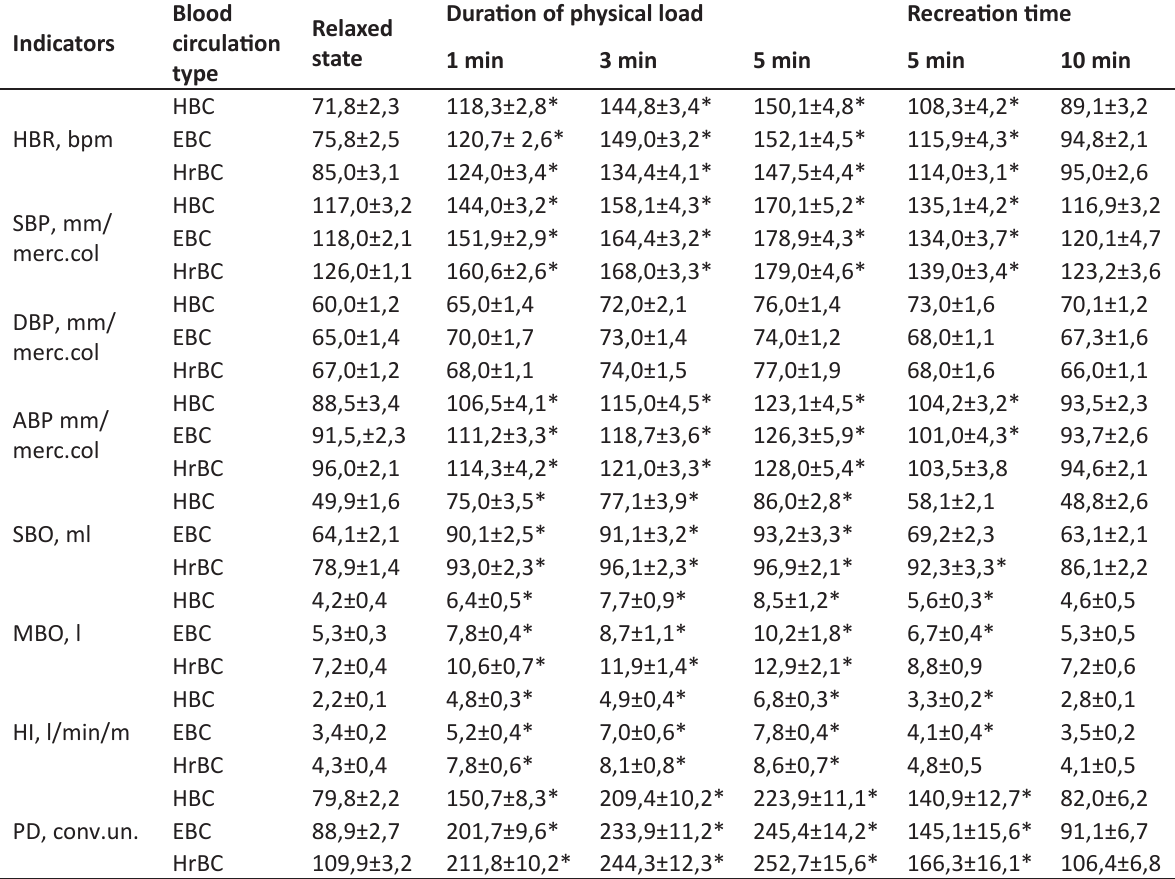
Table 1. Indicators of different types of cardio-hemo-dynamic of 1 st group’s volleyball players before and after standard physical load and in recreation period (M±m,